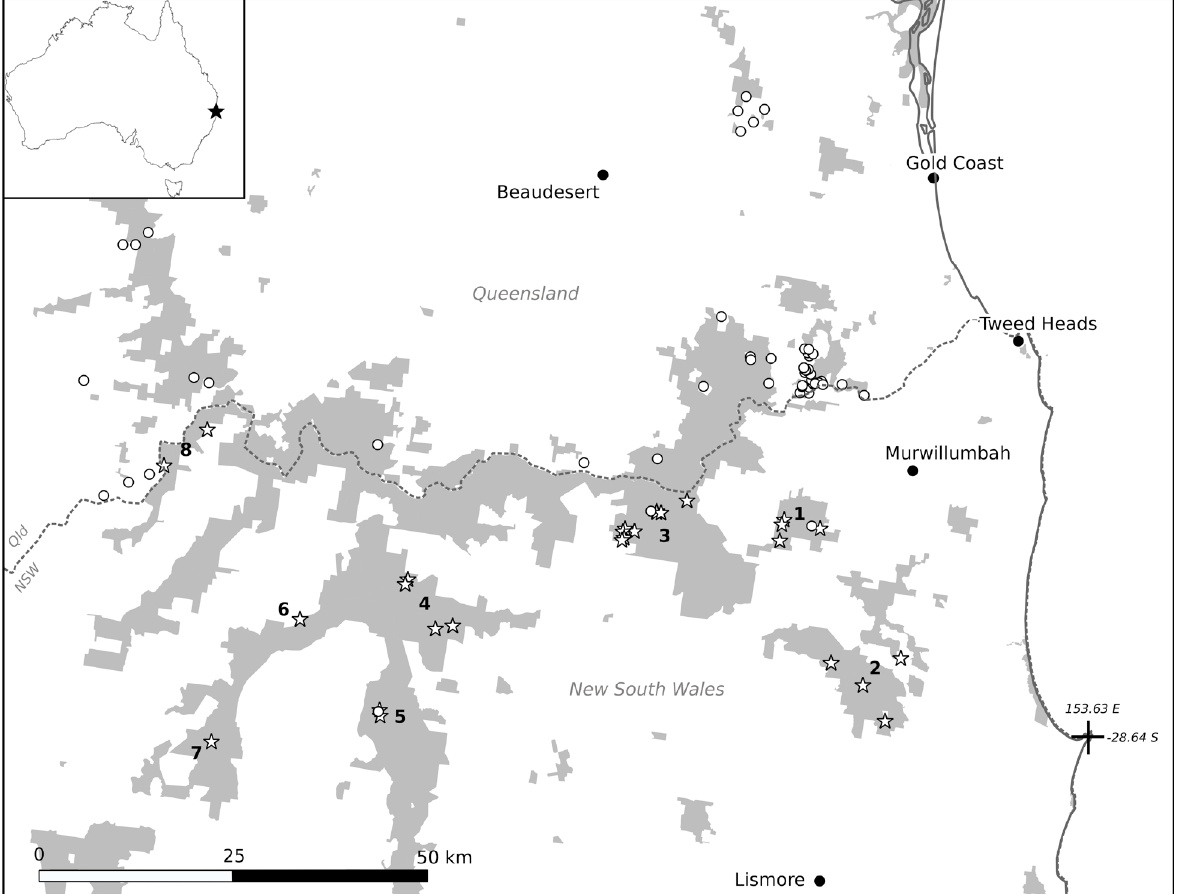
Figure 1. The NSW distribution of the Mountain Crayfish, Euastacus sulcatus , was greatly extended during the study (new sites indicated with stars), and the species was also recorded at all previously known sites (circles). Distinct NSW populations are numbered, as follows: 1 - Mount Warning; 2 - Nightcap; 3 - Border Ranges (including Brindle Creek); 4 - Toonumbar; 5 - Richmond Range; 6 - Yabbra (north); 7 - Yabbra (south); 8 - Koreelah. Known sites of record from Queensland are represented by circles.